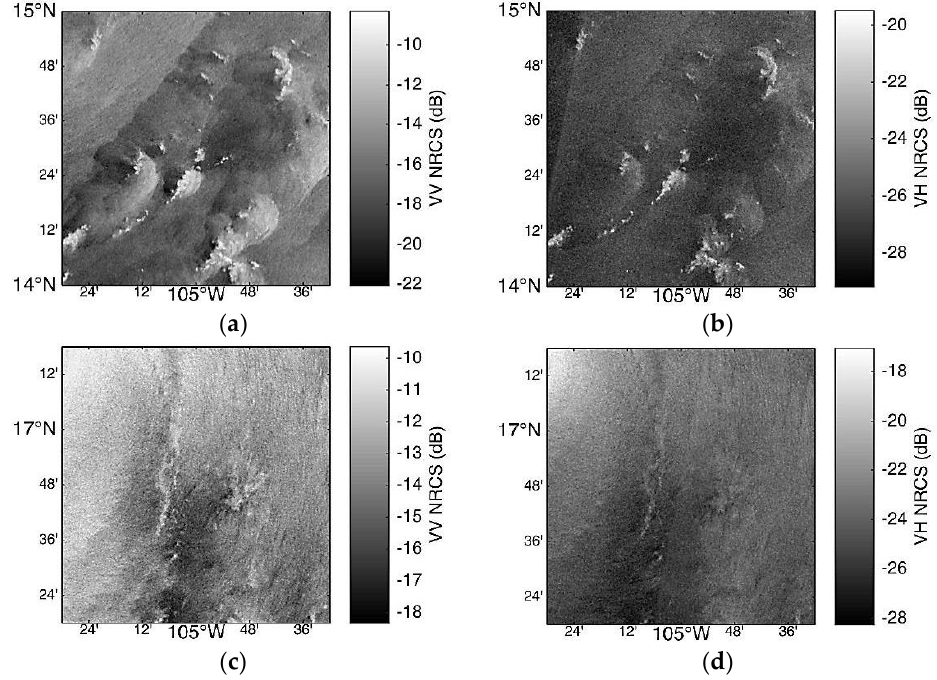
Figure 1. Rain cells in the outer range areas of synthetic aperture radar (SAR) images of Hurricane Patricia. Upper panels ( a , b ) are 125 km from the eye where the wind speed is 15 m/s. Lower panels ( c , d ) are 40 km from the eye where wind speed is 35 m/s. Left panels ( a , c ) show VV normalized radar cross section (NRCS). Right panels ( b , d ) show VH NRCS. Note the differences in the grayscale bars.